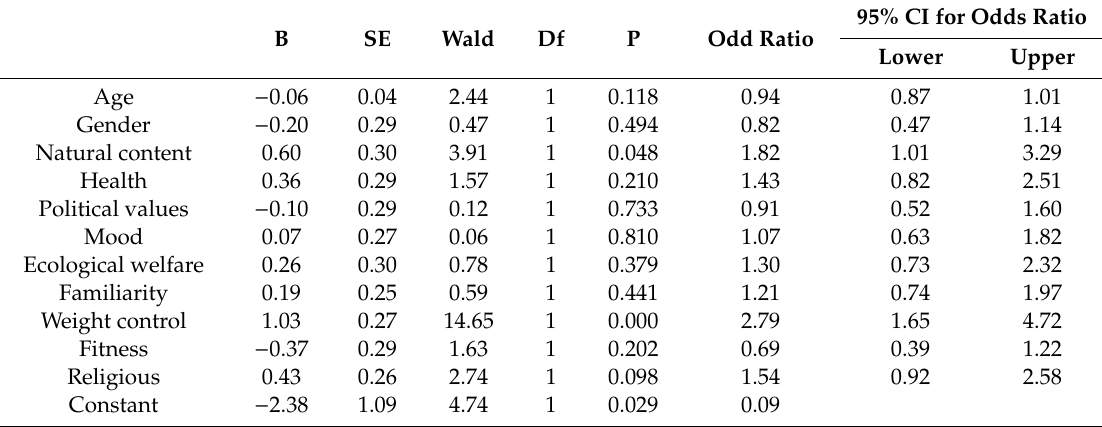
Table 4. The association of demographic characteristics and FCMs with attitudes toward functional